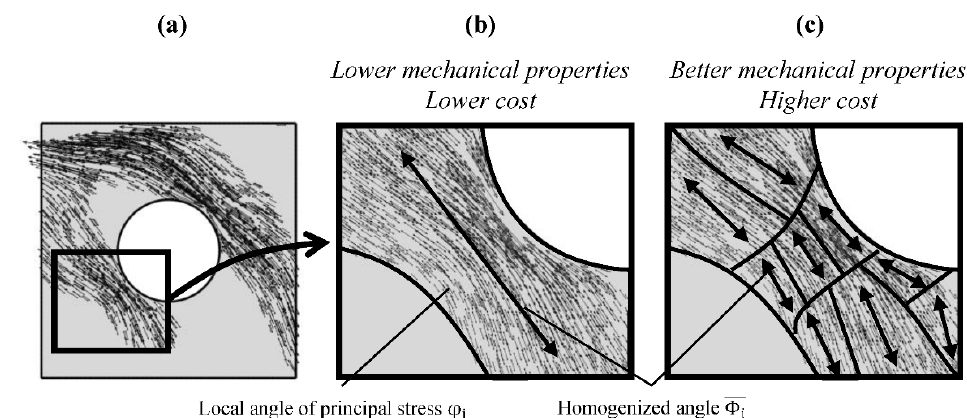
Figure 2. The deviation factor denotes the deviation of the angle between the homogenized angle and the local angles of the principal stress. ( a ) shows the overview of the relevant stresses and their local angles. Large deviation factors lead to lower mechanical properties but also fewer clusters and a lower cost ( b ). Lower deviation factors lead to good mechanical properties but also to more clusters and a higher cost ( c ).